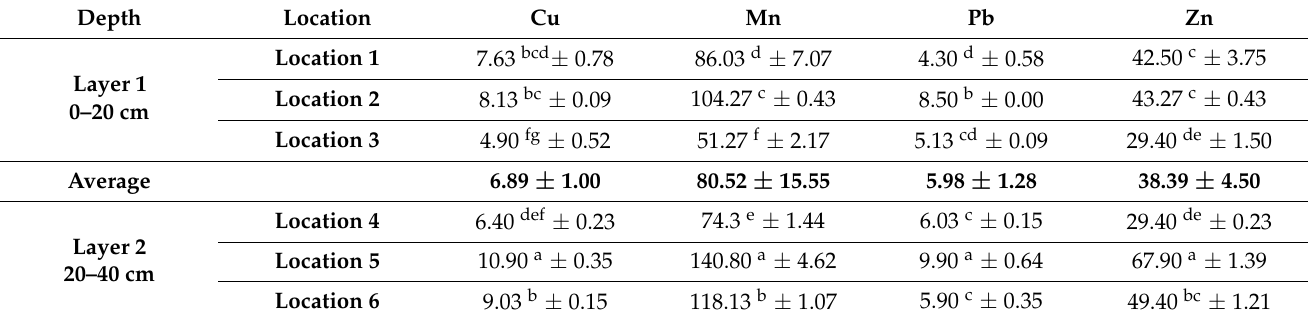
Table 5. Heavy metal concentrations * (mean ± SE; mg/kg soil) in different locations within the soil profile under SI at the end of growing